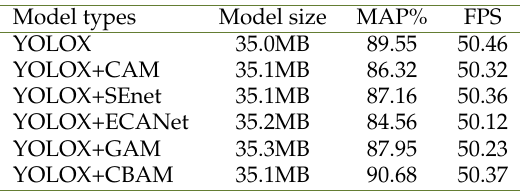
Table 3. Performance comparison of different